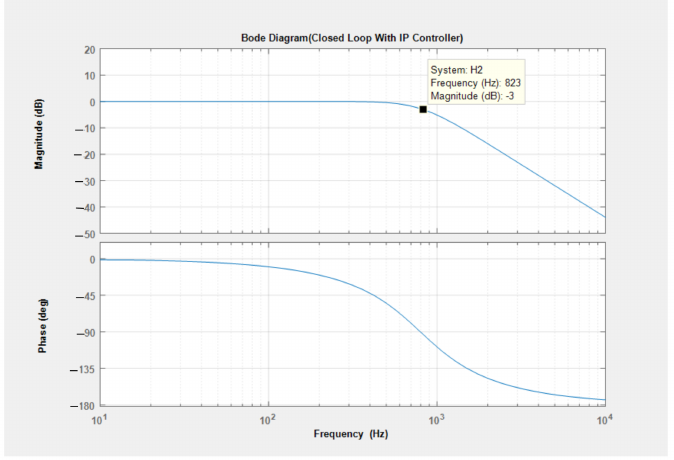
Figure 16. Bode plot of the current controller closed loop T.F with proposed IP controller.